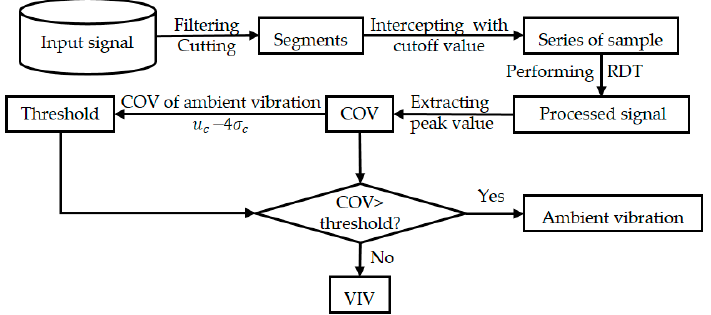
Figure 1. Flowchart of the proposed method (coefficient of variation-COV, Random decrement technique-RDT, Vortex-induced vibration-VIV).